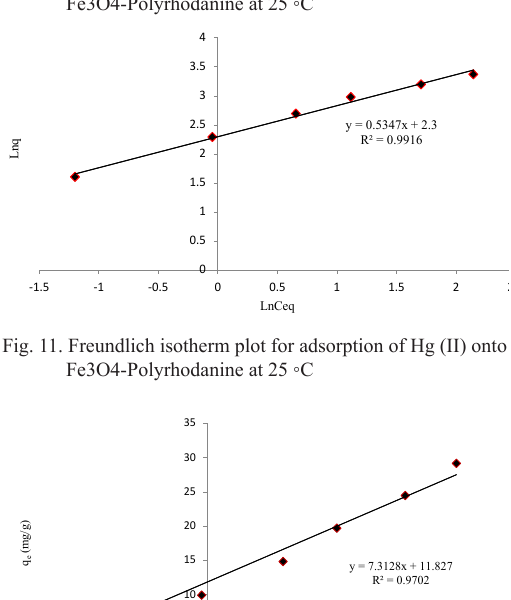
y = 7.3128x + 11.827 R²=0.9702